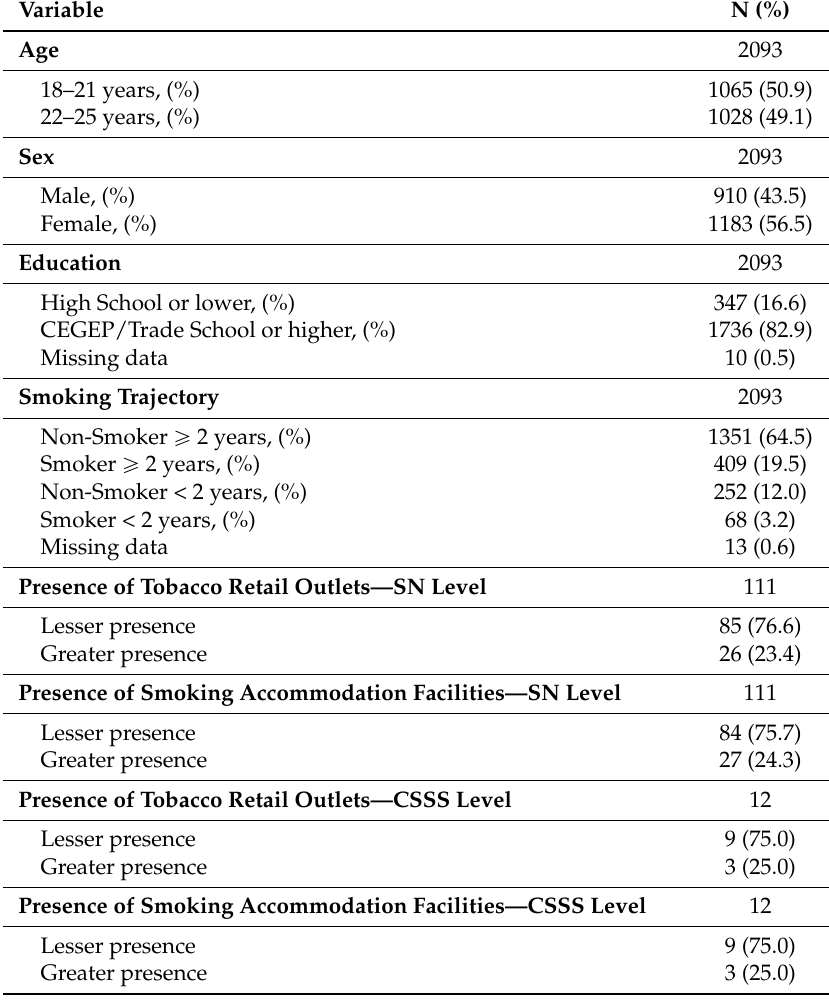
Table 1. Descriptive statistics of the analytical